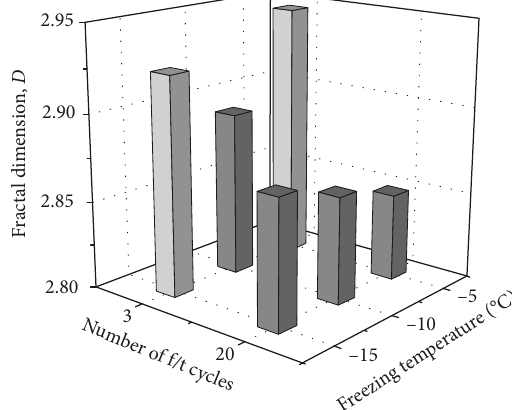
Figure 8: Histogram of the calculated fractal dimension of different soil